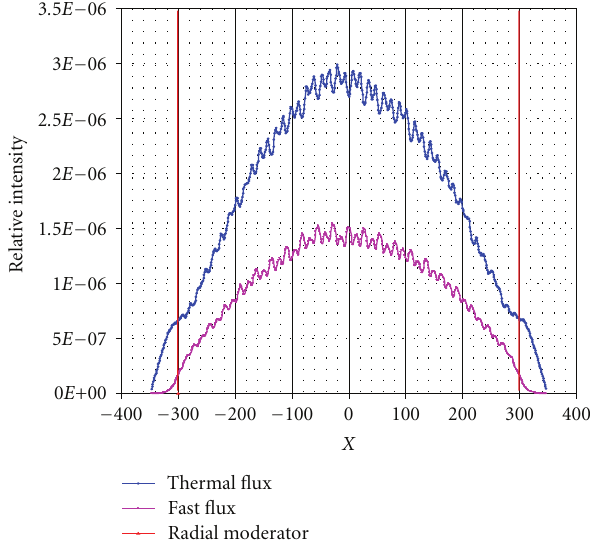
Figure 6: Results from the Atucha-2 MCNP5 3D model-thermal and fast Flux distribution.